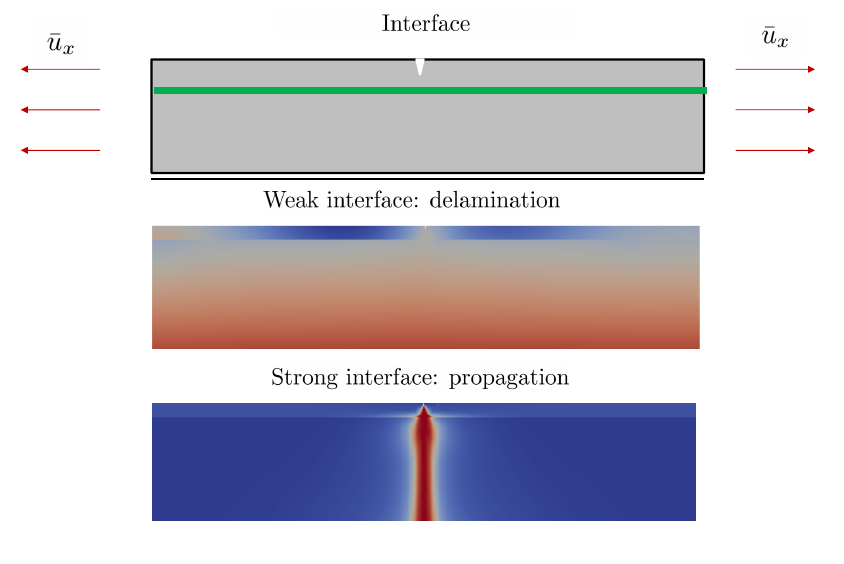
Figure 10. String system subjected to uniaxial displacement. Predictions using PF-CZM for two types of interfaces between similar materials: weak joints with delamination events along the interface and strong joints with continuous crack